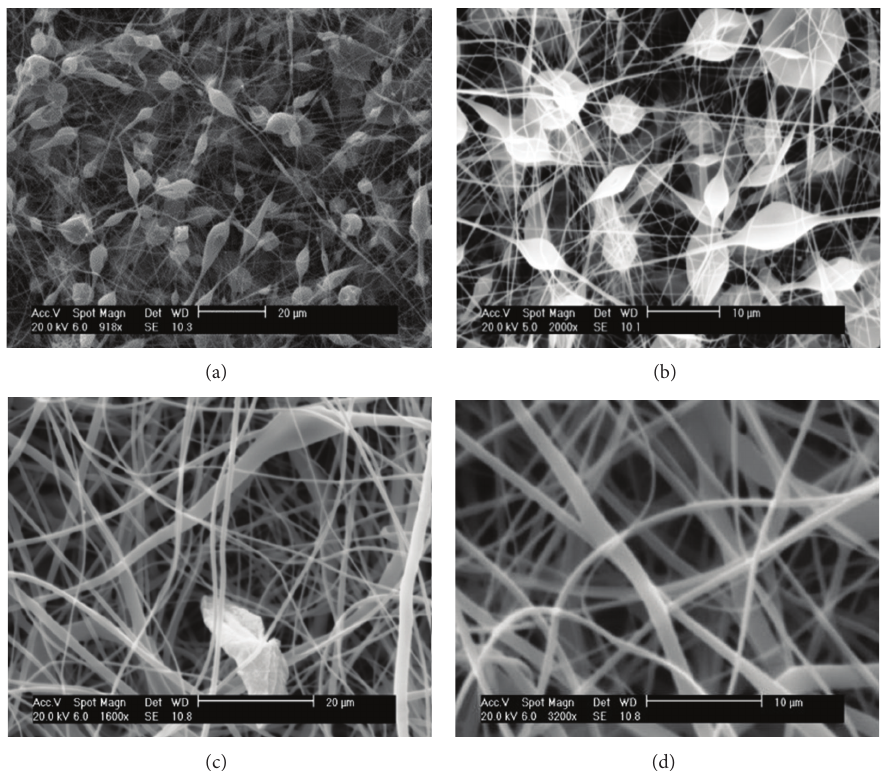
Figure 5: SEM micrographs of CA webs produced from binary mixed solvent systems: acetone: DMAc (2:1) at polymer concentrations: